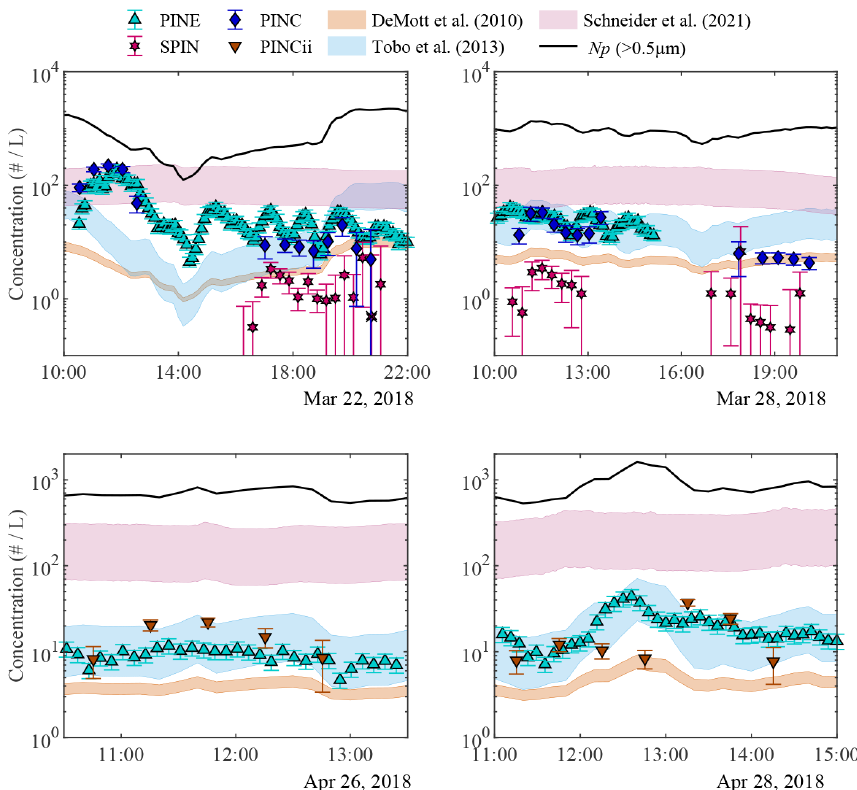
Figure 8. INP concentrations measured between − 29 to − 32 ◦ C for the online INP chambers SPIN, PINC and PINE on 22 and 28 March, and for PINE and PINCii on 26 and 28 April 2018. Aerosol number concentration, N p ( > 0 . 5µm), is represented by the black solid line, and the shaded areas represent the three INP parameterizations from DeMott et al. (2010), Tobo et al. (2013) and Schneider et al. (2021). All parameterization envelopes represent a − 29 ≥ T ≥ − 32 ◦ C cloud temperature window. See Table 2 for more information concerning the thermodynamic conditions at which the chambers were running. Note that the single SPIN data point that includes a black cross on 22 March 2018 is deemed to be below the level of detection, defined as the average background signal plus 1 standard error of the